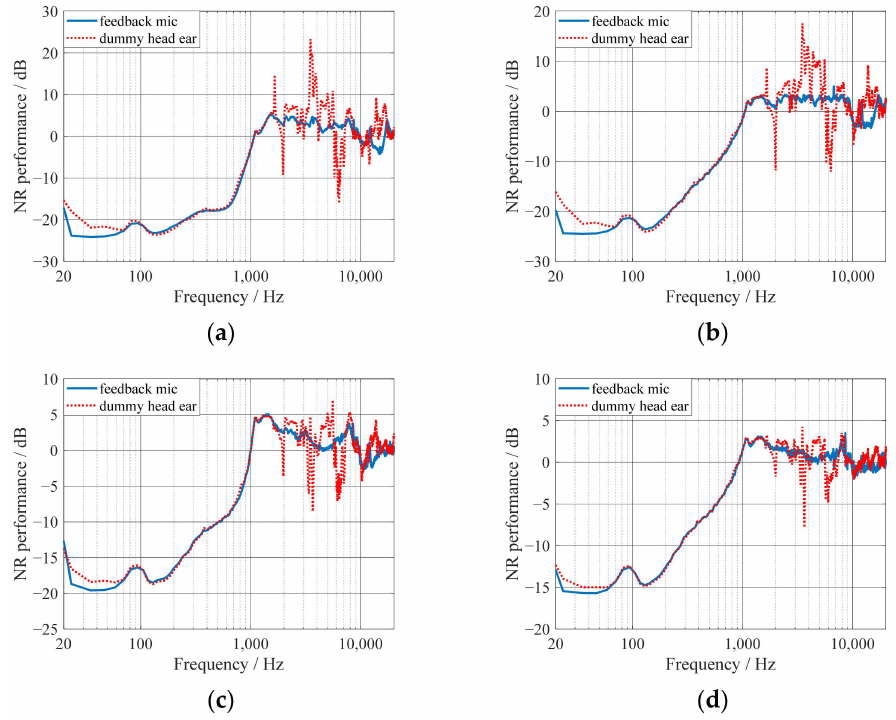
Figure 6. Experiment results of the NR performances: ( a ) δ = 5 dB and ( b ) δ = 3 dB with Method 1, ( c ) δ = 5 dB and ( d ) δ = 3 dB with Method